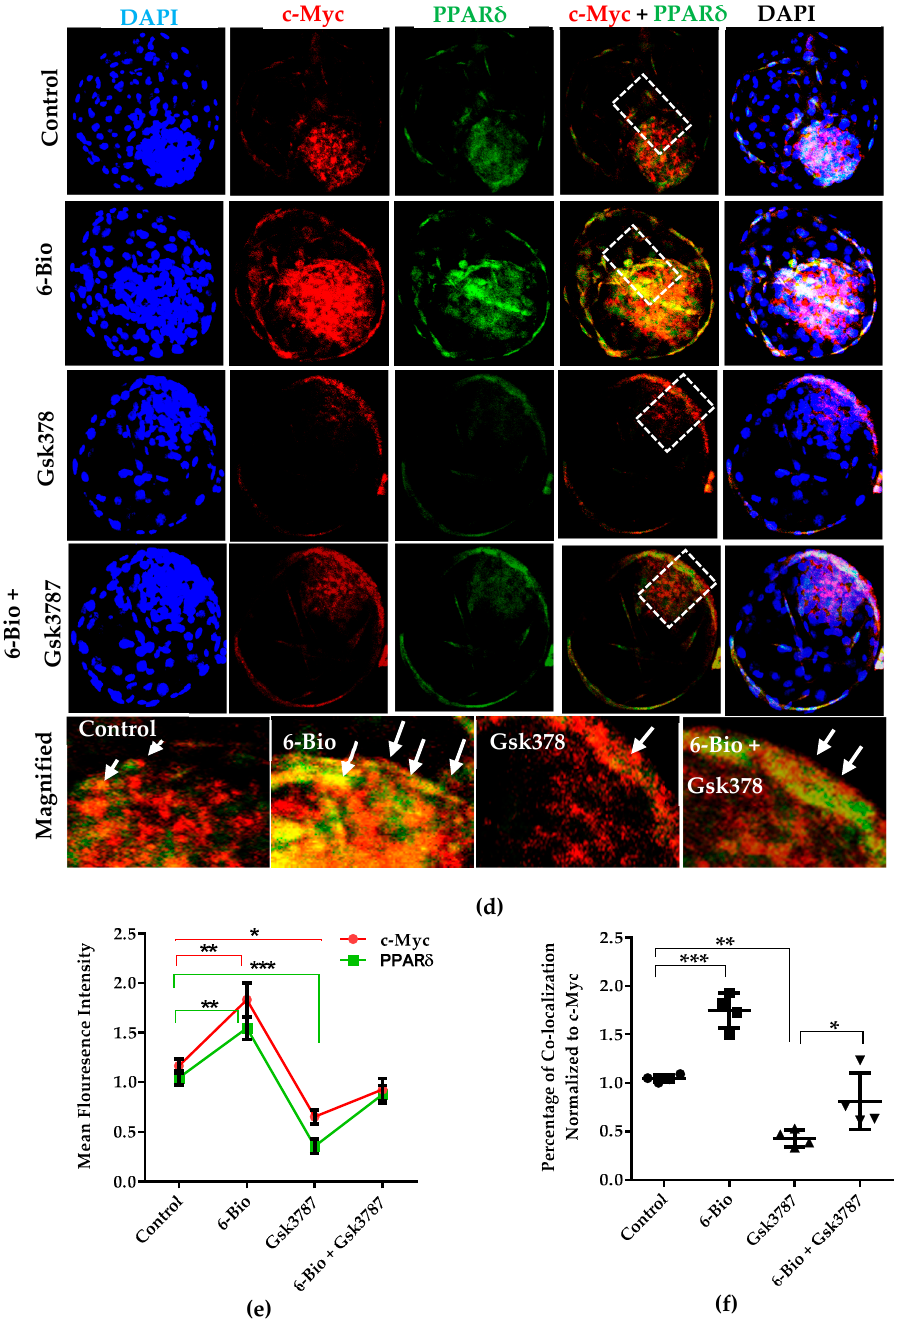
Figure 4. Wnt induced PPAR δ signaling upregulates c-Myc expression during bovine BL development. ( a ) Bar graphs represents the treatment of Wnt agonist (6-Bio; 400 nM), PPAR δ antagonist (Gsk3787; 15 µM) and their co-treatment effect on bovine embryonic development to the BL stage. Data presented as a result of ± standard error of mean(SEM) from 11 replicates. ( b ) qRT-PCR analysis of c-Myc and CyclinD1 expression by Gsk3787 treated group. n = 5. ( c ) Immunofluorescence imaging showing co-localization of PPAR δ (green) with c-Myc (red) in response to 6-Bio stimulation. Arrows indicate overlapping of PPAR δ and c-Myc expression merge in Yellow. Nuclei counterstained with DAPI (blue). Higher magnification of the box regions shown at the bottom ( d – e ) Bar graph represent the quantification of mean fluorescence intensities and percentage of co-localization of PPAR δ with c-Myc. All data are mean ± SEM from three independent sets of experiments (n = 20 BLs). * p < 0.05; ** p < 0.01; *** p < 0.001 indicates significant difference. Original magnification 100×.